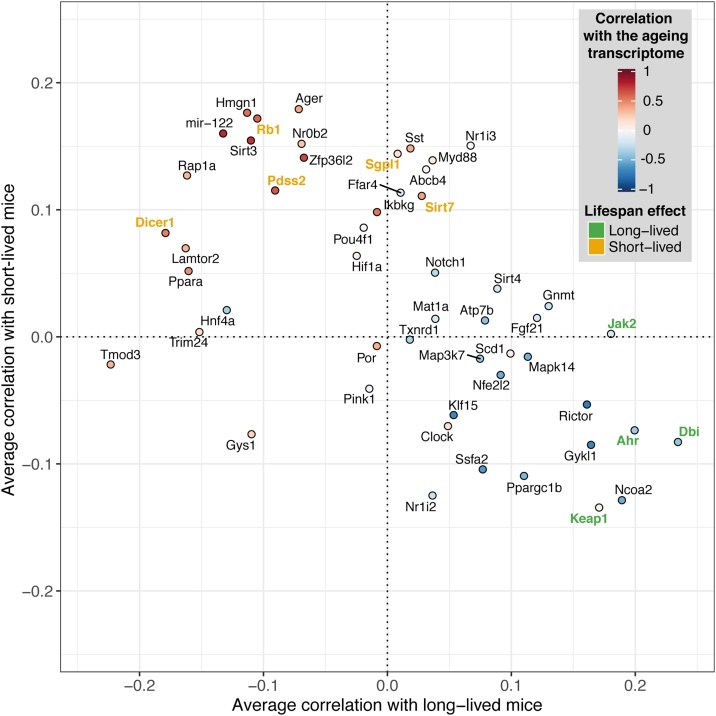
Correlation between the transcriptomes of long- and short-lived mice and that induced by 51 different gene knockouts. Correlations were calculated using enrichments scores of the gene sets in Fig. 3A. The colours of the dots represent the correlations with the ageing transcriptome. Labels represent the name of the gene knocked out. Gene knockouts known to lengthen or shorten lifespan in animal models are coloured in green and yellow, respectively.